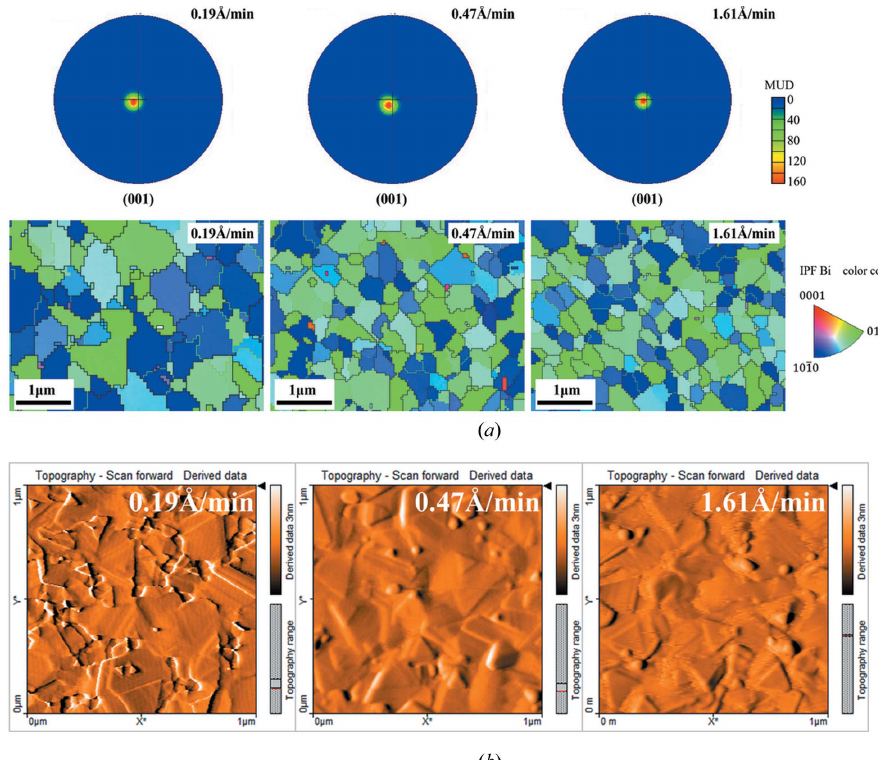
Figure 9 The microstructure of the low-melting-point metal polycrystalline Bi thin films with different growth rates (the thickness is 30 nm and the substrate temperature is 70 (cid:2) C). ( a ) EBSD images of Bi thin films (thickness 30 nm) with different growth rates at 0.19, 0.47 and 1.61 A˚ min (cid:5) 1 . The color code shows the crystallographic orientation with respect to [0001]. ( b ) AFM images (1 (cid:4) 1 m m) of Bi thin films with different growth rates at 0.19, 0.47 and 1.61 A˚ min (cid:5) 1